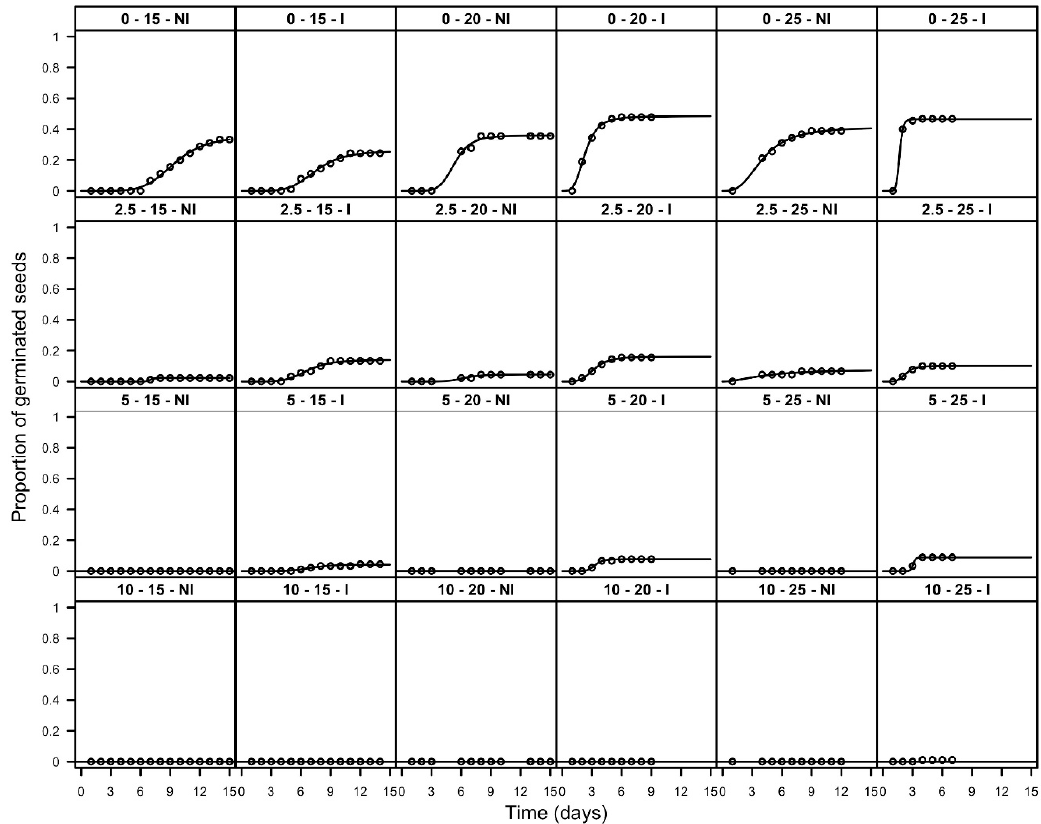
Figure 2. Emergence trends in assays conducted at different burial depth (0; 2.5; 5; 10 mm), temperatures (15, 20 and 25 °C) and pre-treatments (I: water imbibition and light exposure for two days; NI: no water imbibition and no light exposure). The heading of each panel plot represents the ‘depth - temperature - pre-treatment’ combination. The assays were conducted under a photoperiod of 12 h light and 12 h darkness.